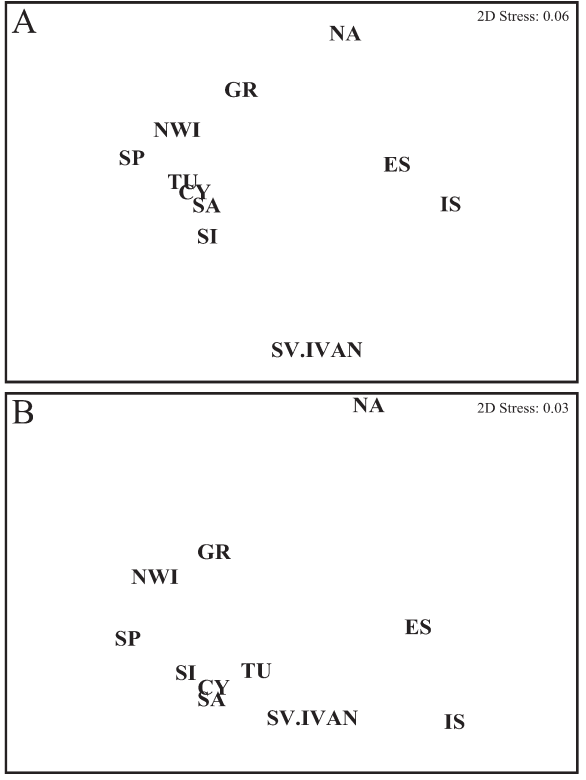
Fig . 3. – MDS analyses (Bray-Curtis Similarity) comparing the Sv. Ivan Island syllid fauna to those of the ten Mediterranean coastlines following Musco and Giangrande (2005a). A, faunistic comparison. B, bioclimatic comparison. NA, N Adriatic; SP, Spanish; NWI, NW Italian; ES, E Sicilian; IS, Israeli; CY, Cypriot; TU, Turkish Aegean; GR, Greek Aegean coastlines; SI, the Ionian; and SA, the Adriatic coastlines of the Salento